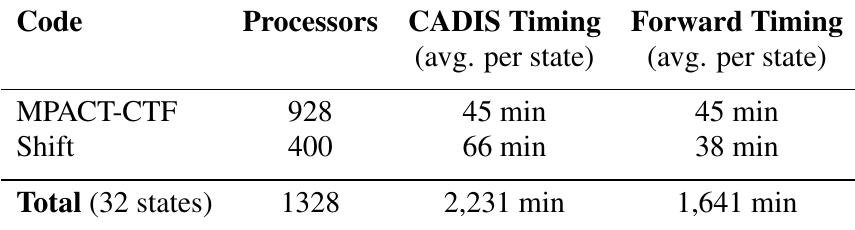
Table 1: VERA computing resources for WBN1 vessel fluence